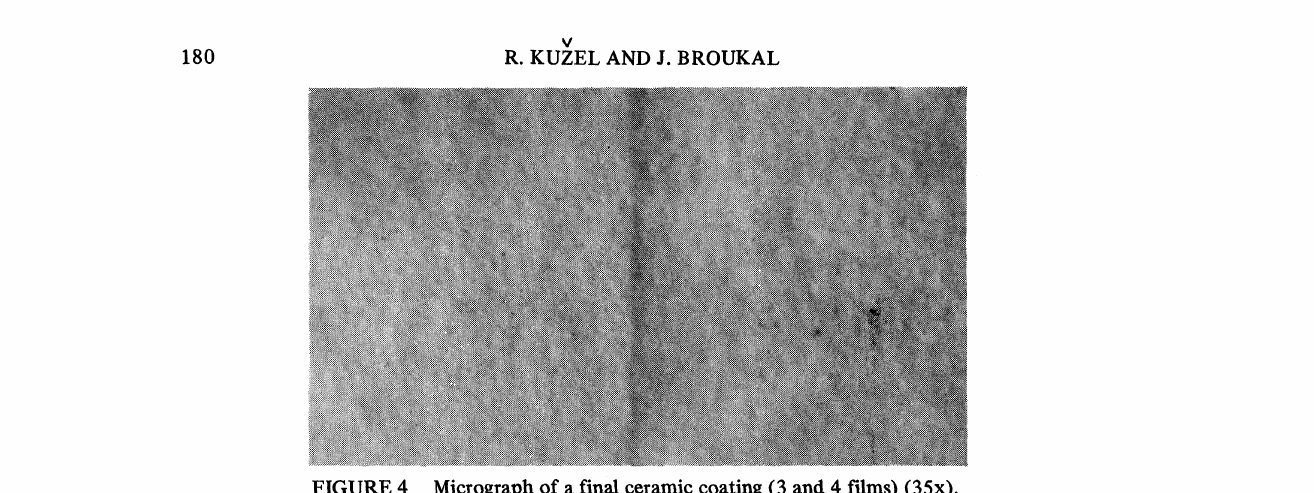
FIGURE 4 Micrograph of a final ceramic coating (3 and 4 f’flms) (35x).